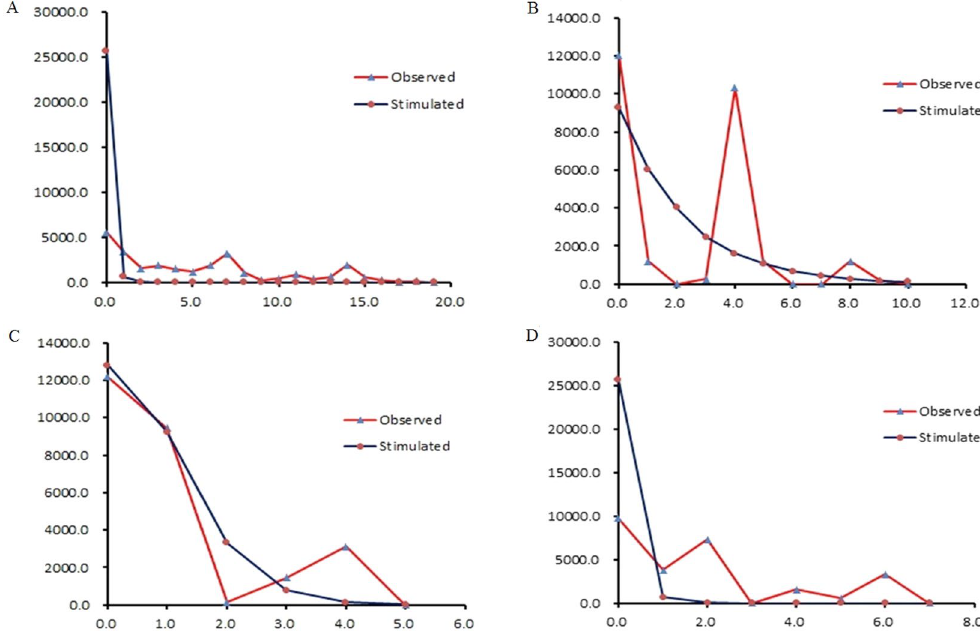
Figure 9. Observed and simulated mismatch distributions. ( A , B , C and D ) represent concatenated sequences, COI , ND1 and ND5 , respectively. The horizontal axis represents the number of pairwise differences, and the vertical axis represents the relative frequency.